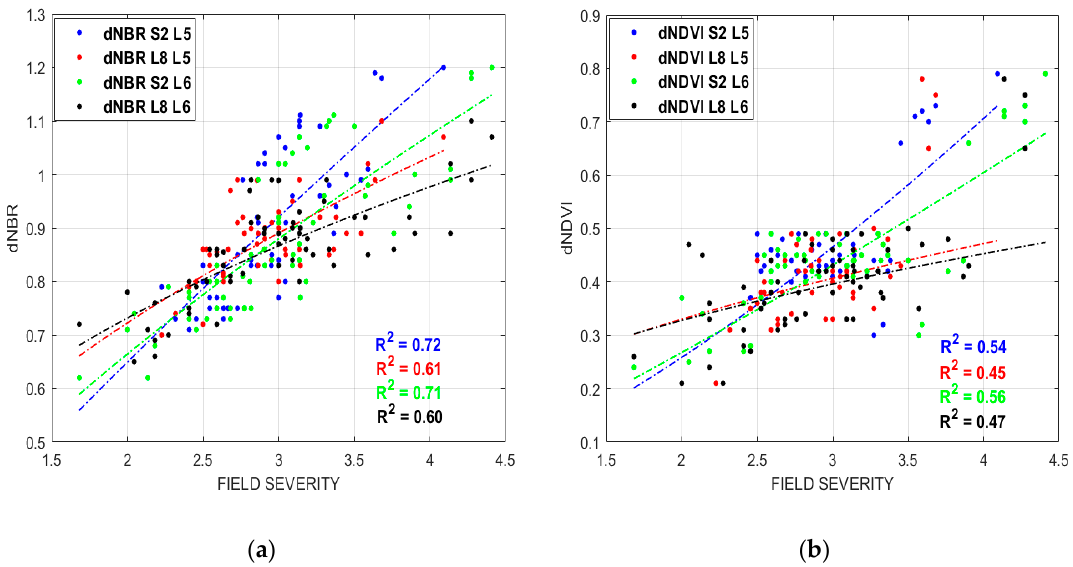
Figure 4. ( a ) Regression model between dNBR indices and field severity; ( b ) regression model between dNDVI (Di ff erenced Normalized Di ff erence Vegetation Index) indices and field